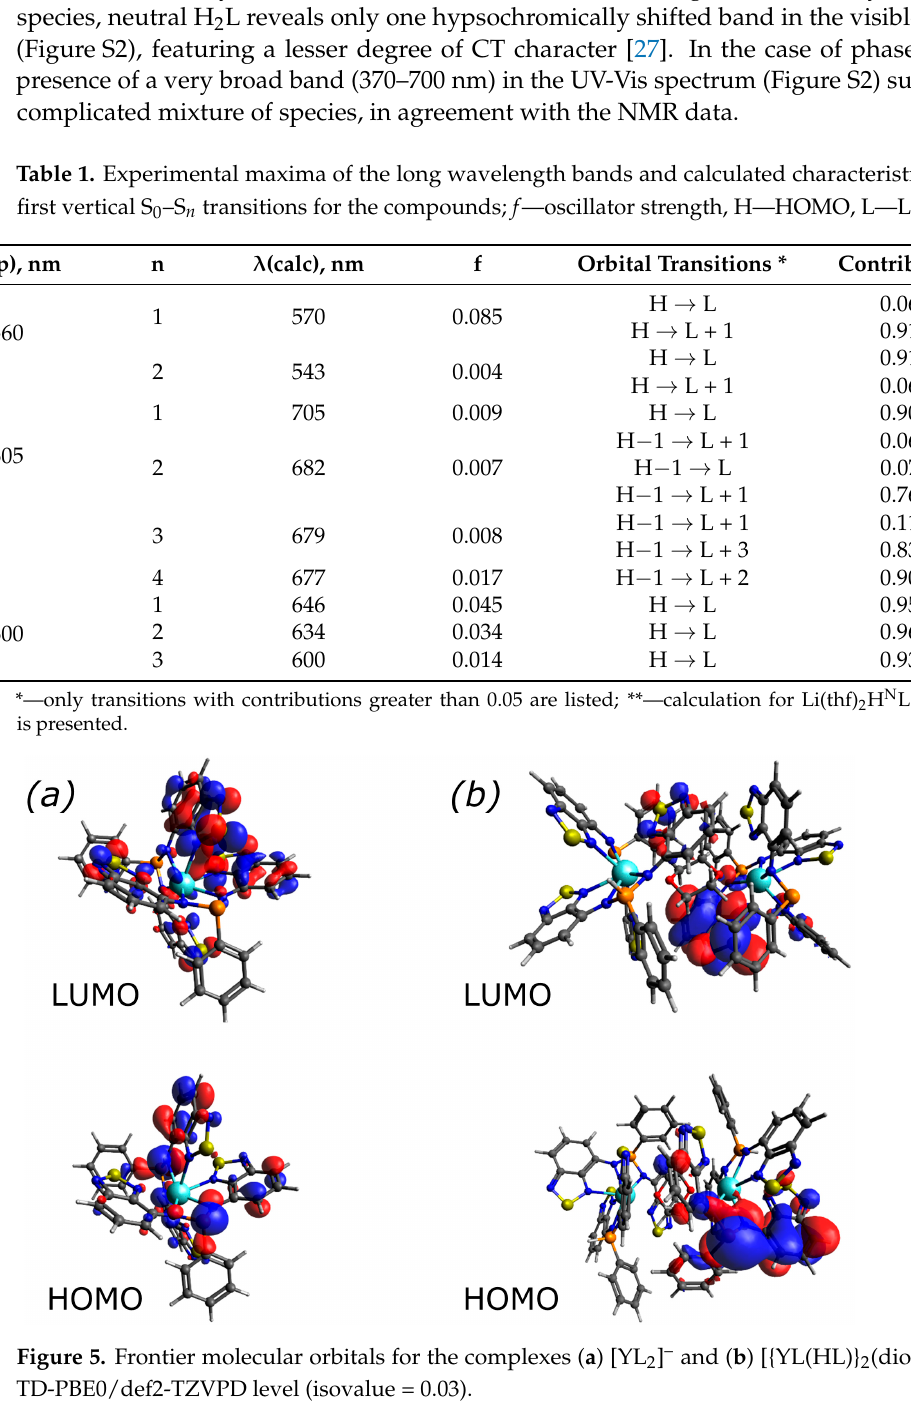
Table 1. Experimental maxima of the long wavelength bands and calculated characteristics of the first vertical S 0 –S n transitions for the compounds; f —oscillator strength, H—HOMO, L—LUMO.